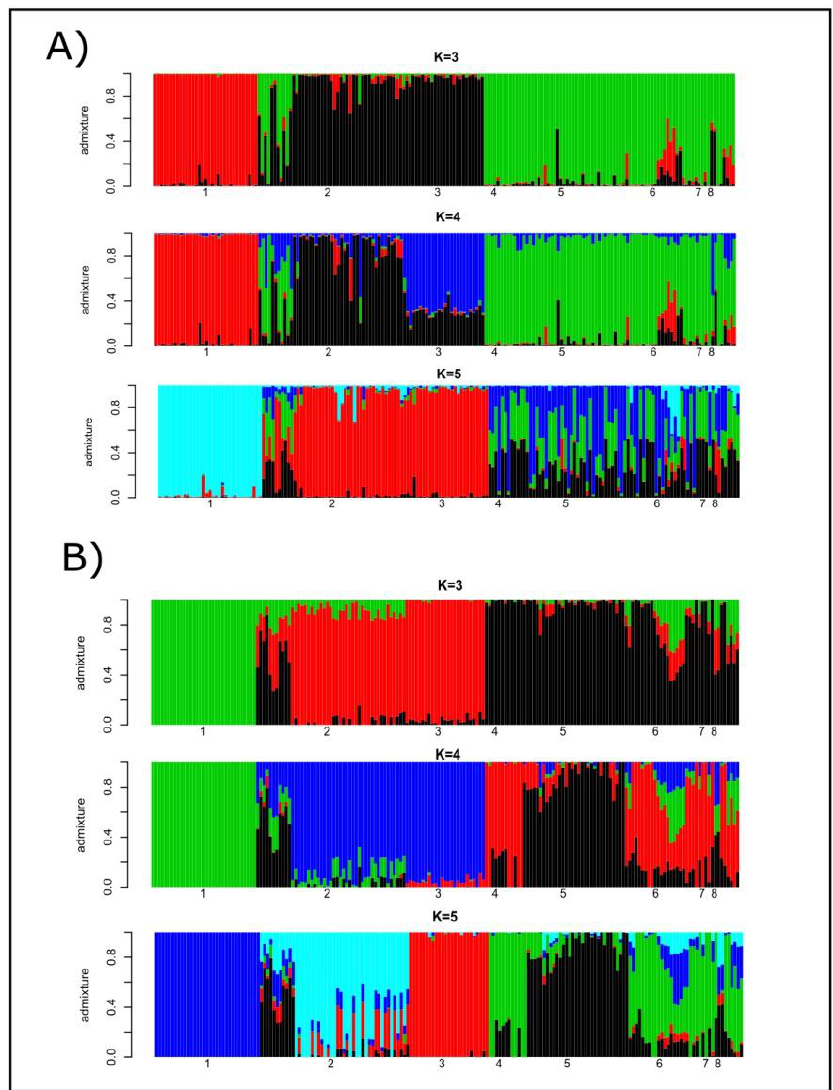
Figure 1. Barplots of individual ancestries for K = 3, K = 4 and K = 5 estimated using the program STRUCTURE on microsatellite genotypes (Plot A ) and the program ADMIXTURE v1.23 on SNP polymorphism (Plot B ). Numbers mean the following: (1) Lagunaire; (2) N’Dama (Burkina Faso); (3) N’Dama (Congo); (4) Zebu Peul (Benin);(5) Zebu Peul (Burkina Faso); (6) Borgou; (7) Lobi; and (8) Zou. Populations from 1 to 3 belong to West African taurine cattle, populations 4 and 6 belong to West African zebu cattle, and populations from 6 to 8 belong to sanga